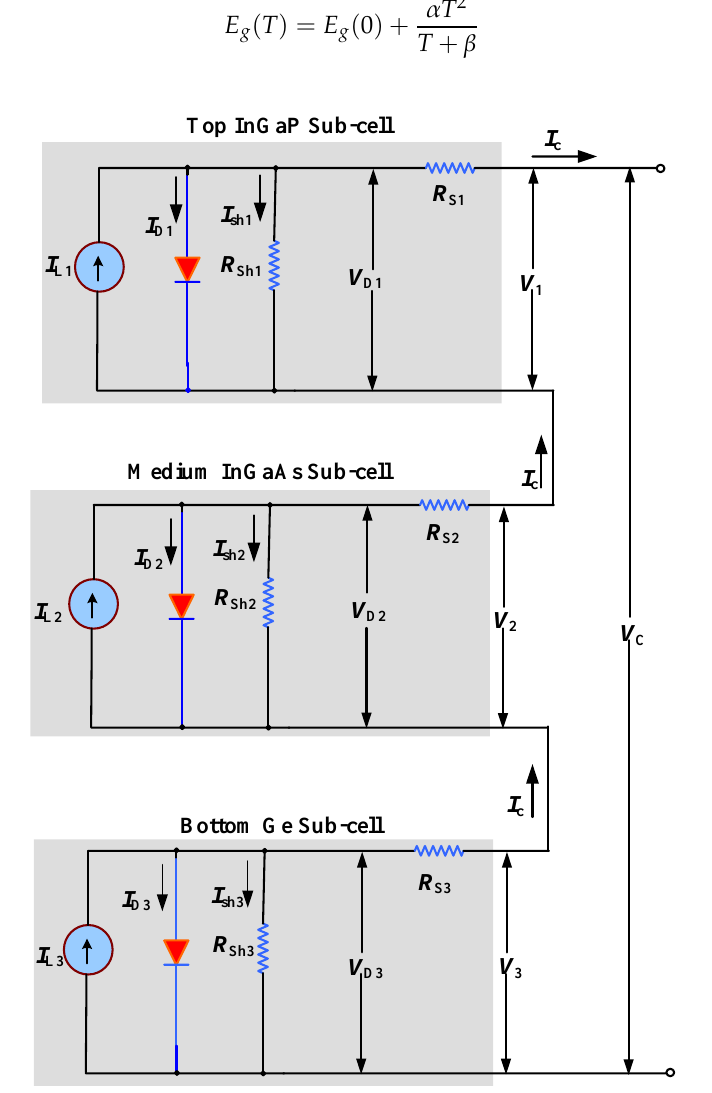
Figure 2. Model of triple-junction solar cell (TJSC).